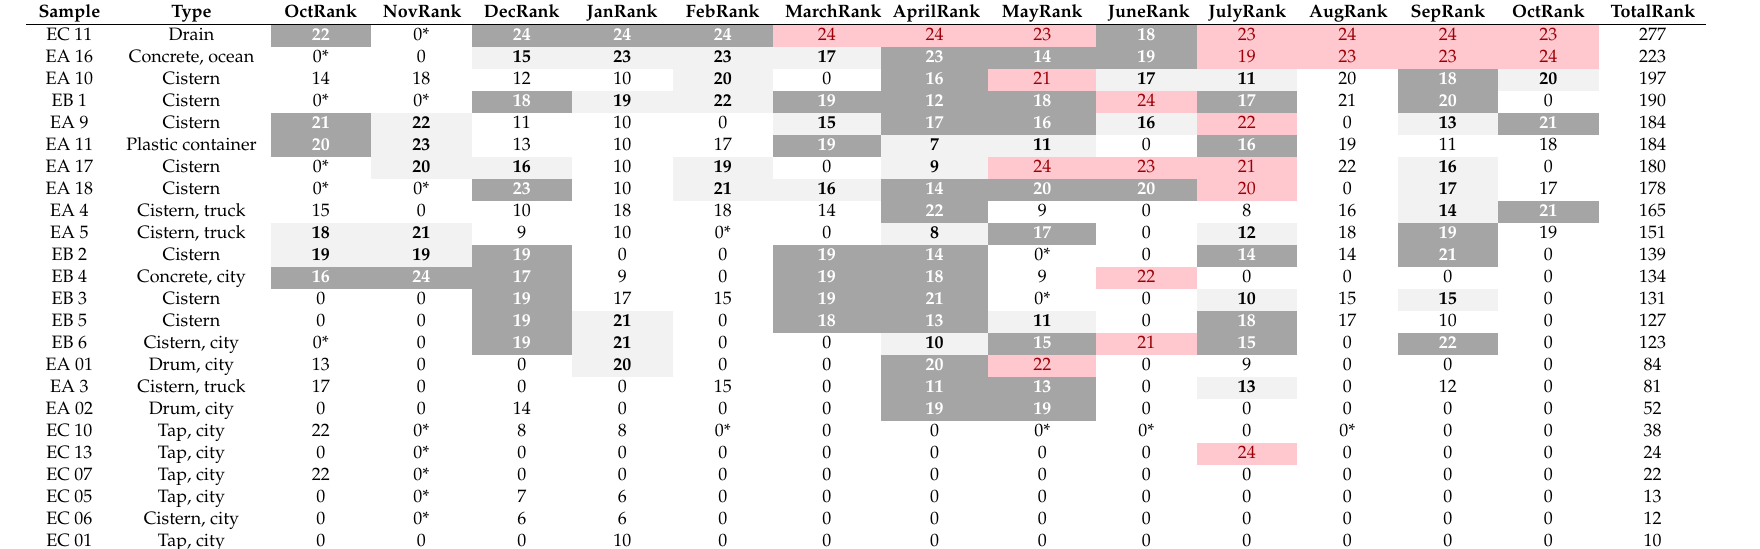
Table 1. Monthly Fecal Coliform counts for each of the tested water